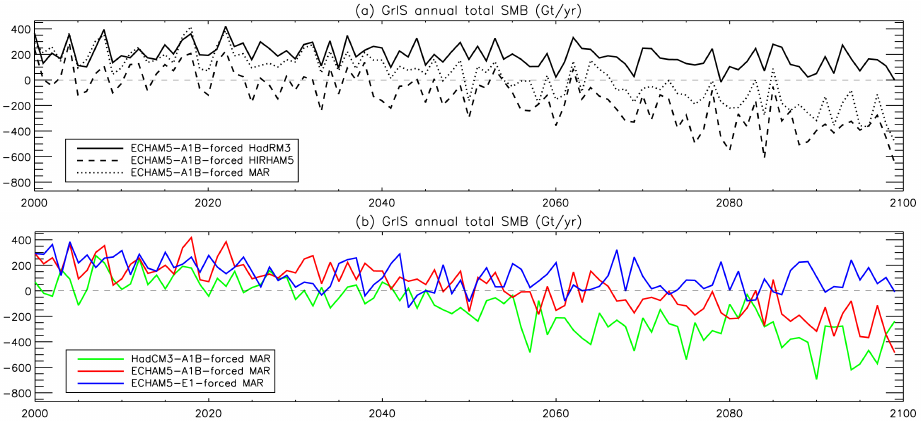
Fig. 16. (a) Time series of GrIS total annual SMB for the three RCMs, forced by ECHAM5-A1B boundary conditions. (b) Time series of GrIS total annual mass balance for MAR, forced by all three sets of future boundary